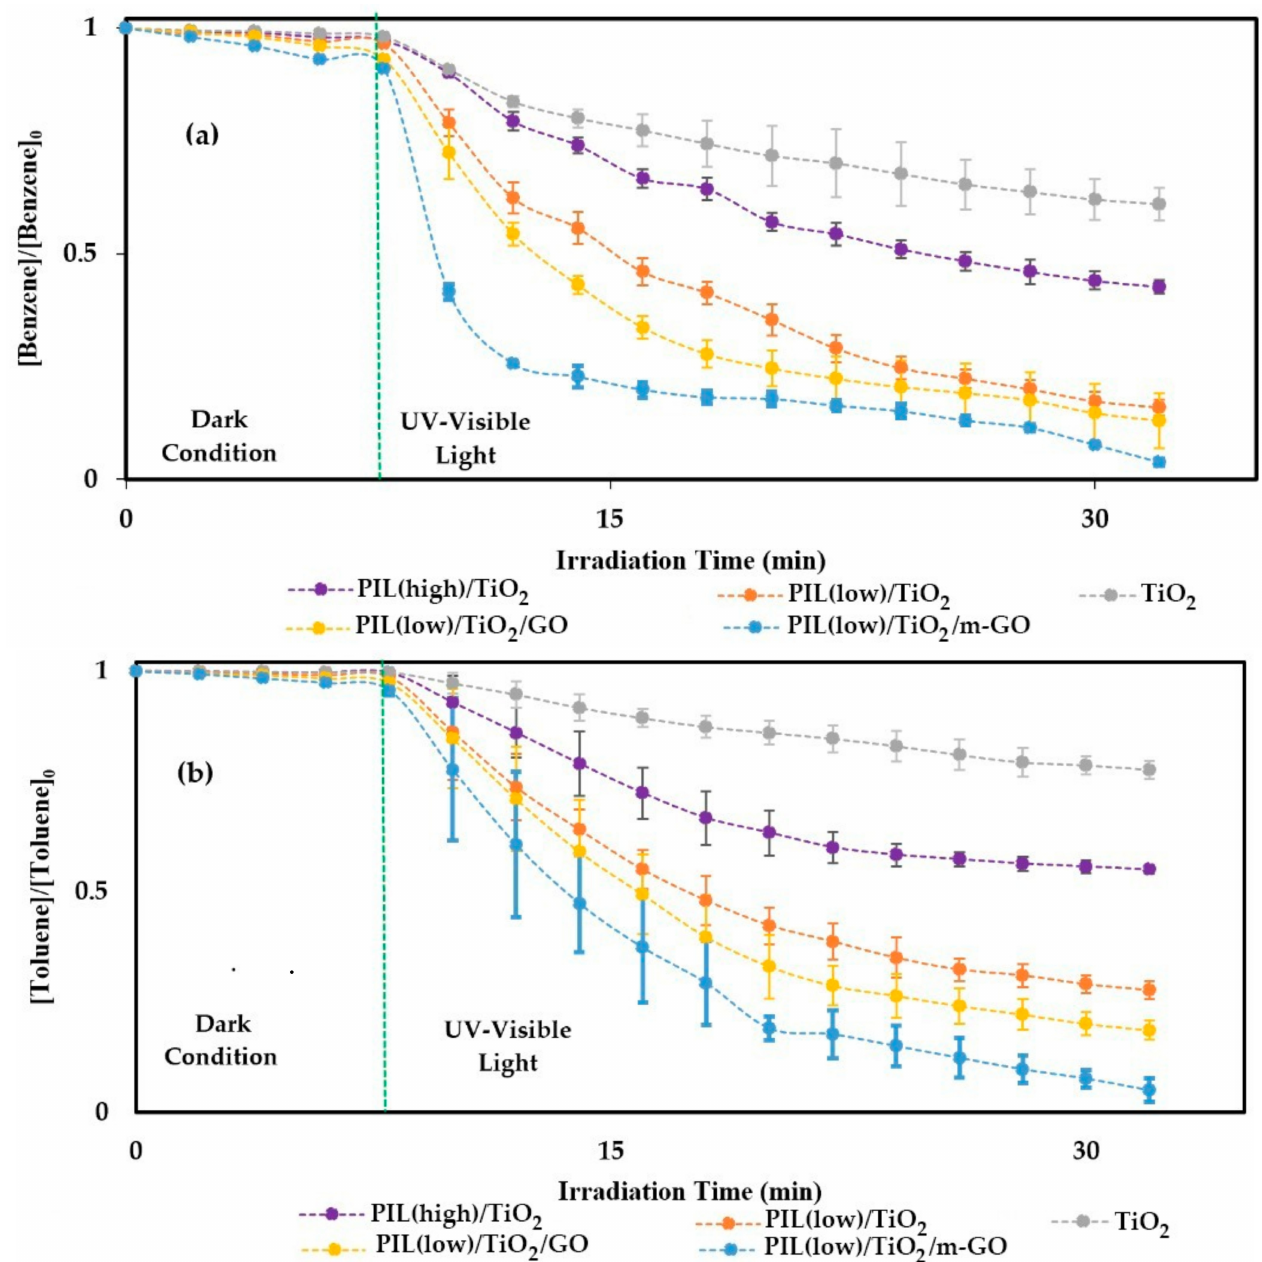
Figure 8. Photodegradation of ( a ) benzene and ( b ) toluene with irradiation time over five samples (first 8 min under dark and then 24 min under UV–visible radiation) of TiO 2 , PIL(high)@TiO 2 , PIL(low)@TiO 2 , PIL(low)@TiO 2 (97 wt.%)/GO (3 wt.%) and PIL(low)@TiO 2 (97 wt.%). /m-GO (3 wt.%).